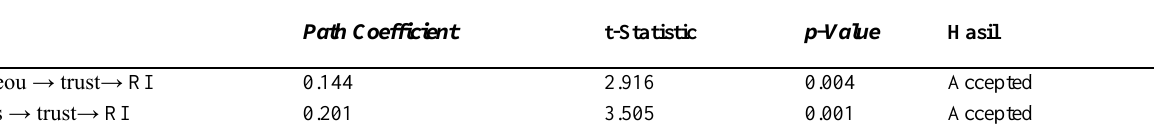
Table 5: B Indirect Hypothesis